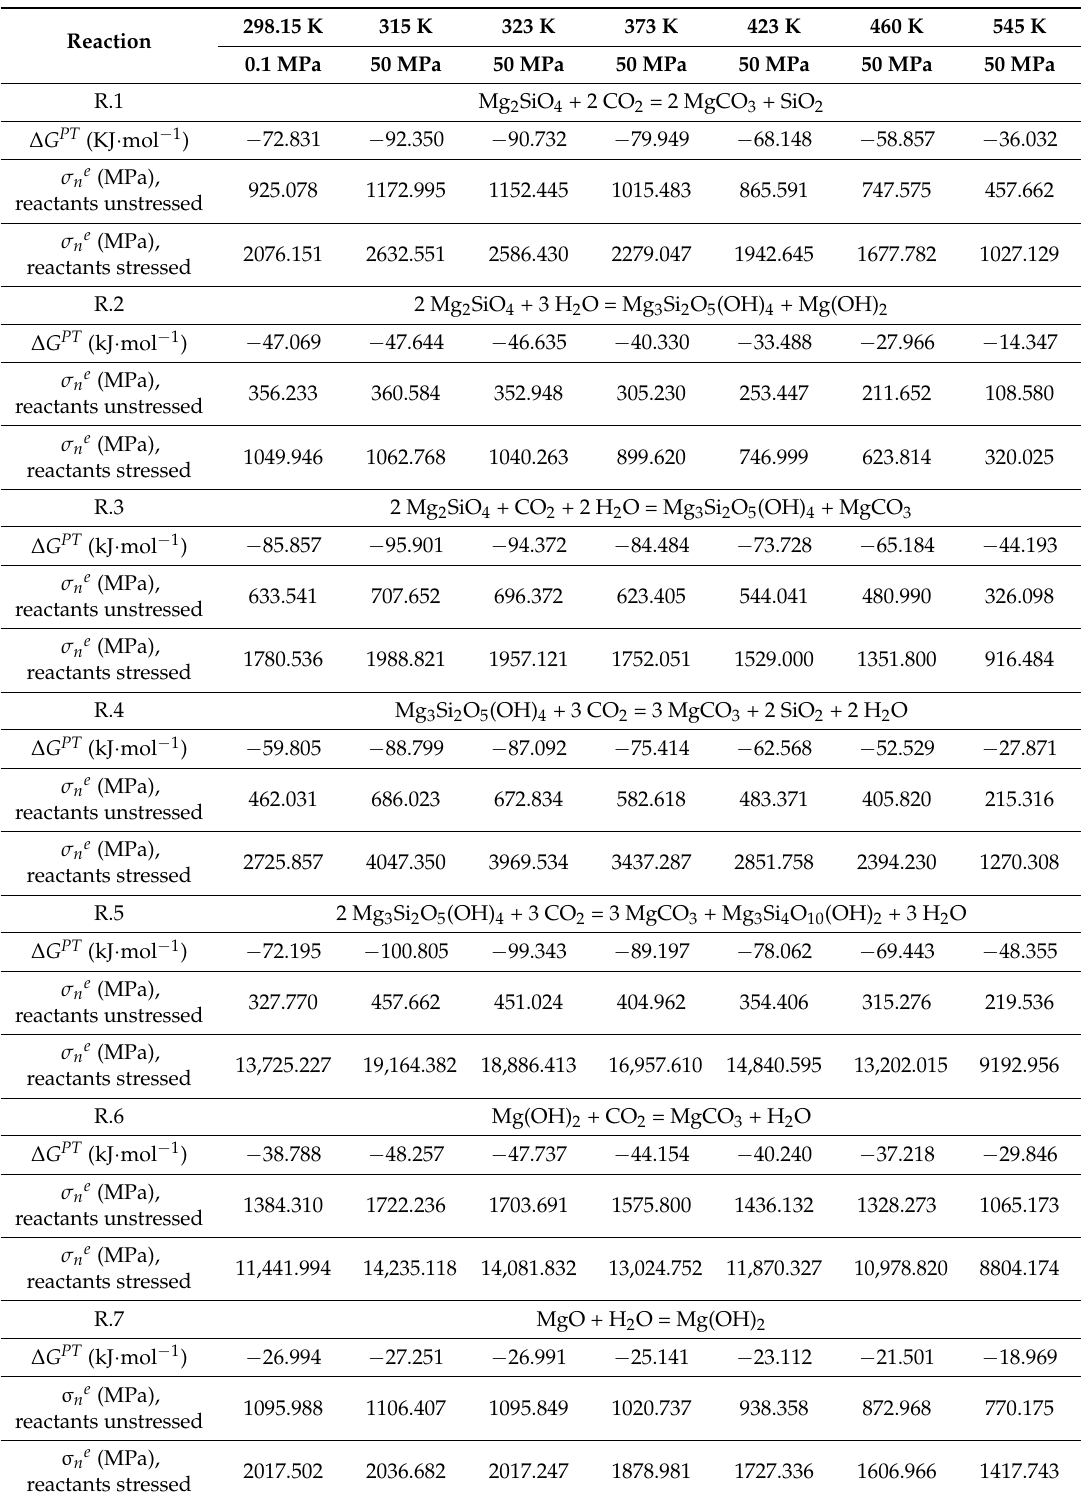
Table 6. Free energies of reaction under hydrostatic conditions and maximum effective stress σ e n (MPa) generated by confined precipitation in fractures. Calculations were performed assuming either unstressed reactants (outside the confined zone) or stressed reactants (replacement of wallrock in a confined fracture) for the main reactions involved in the carbonation and hydration of